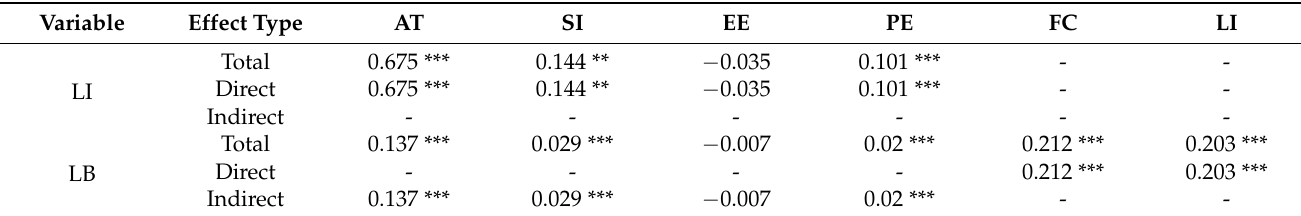
Table 7. Total effect, direct effect, and indirect